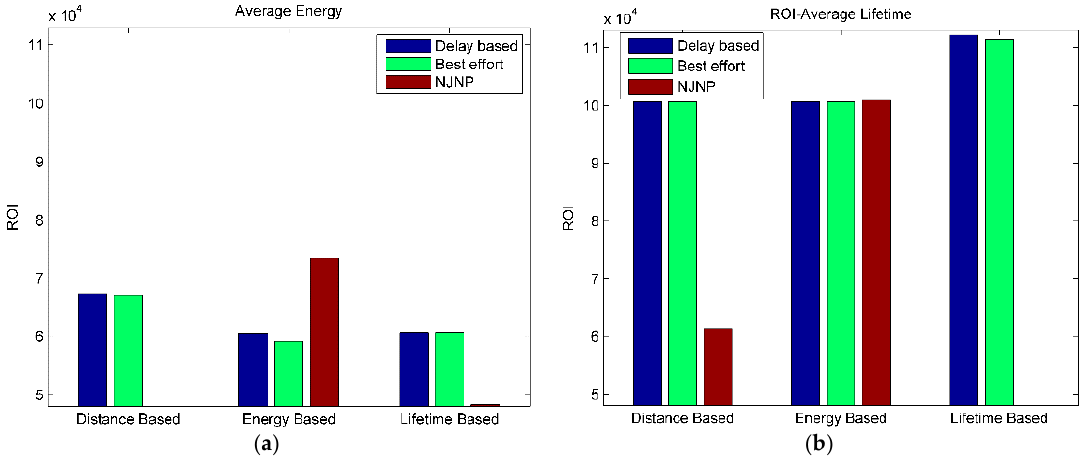
Figure 10. Result of return on investment ( ROI ) analysis of battery.